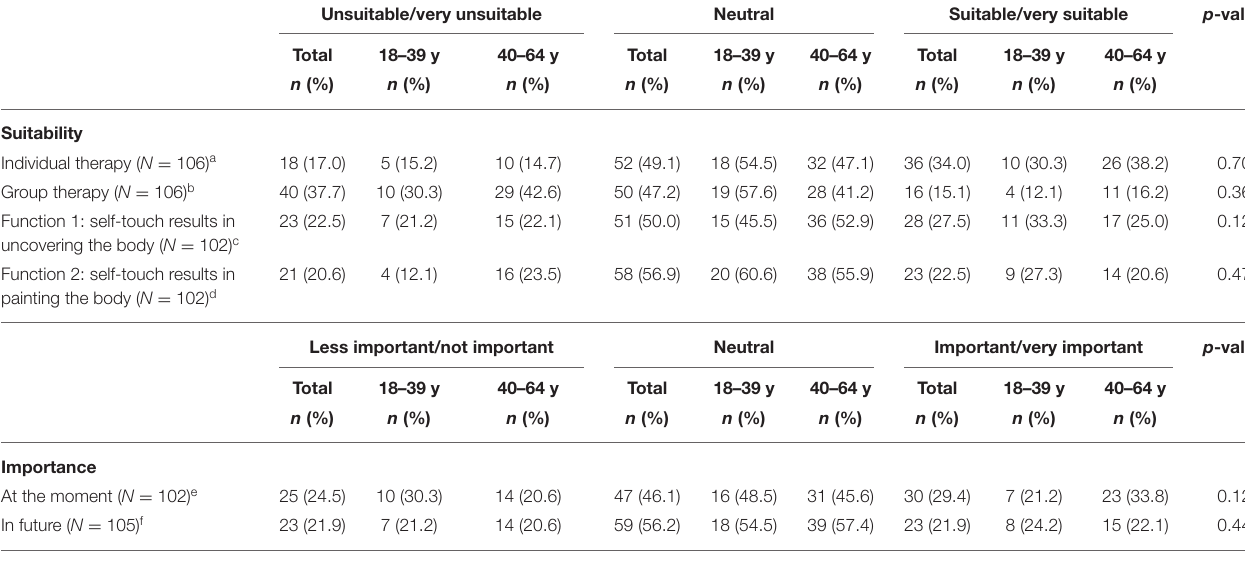
TABLE 3 | Suitability/importance of virtual reality (VR) in the therapy of overweight/obesity.